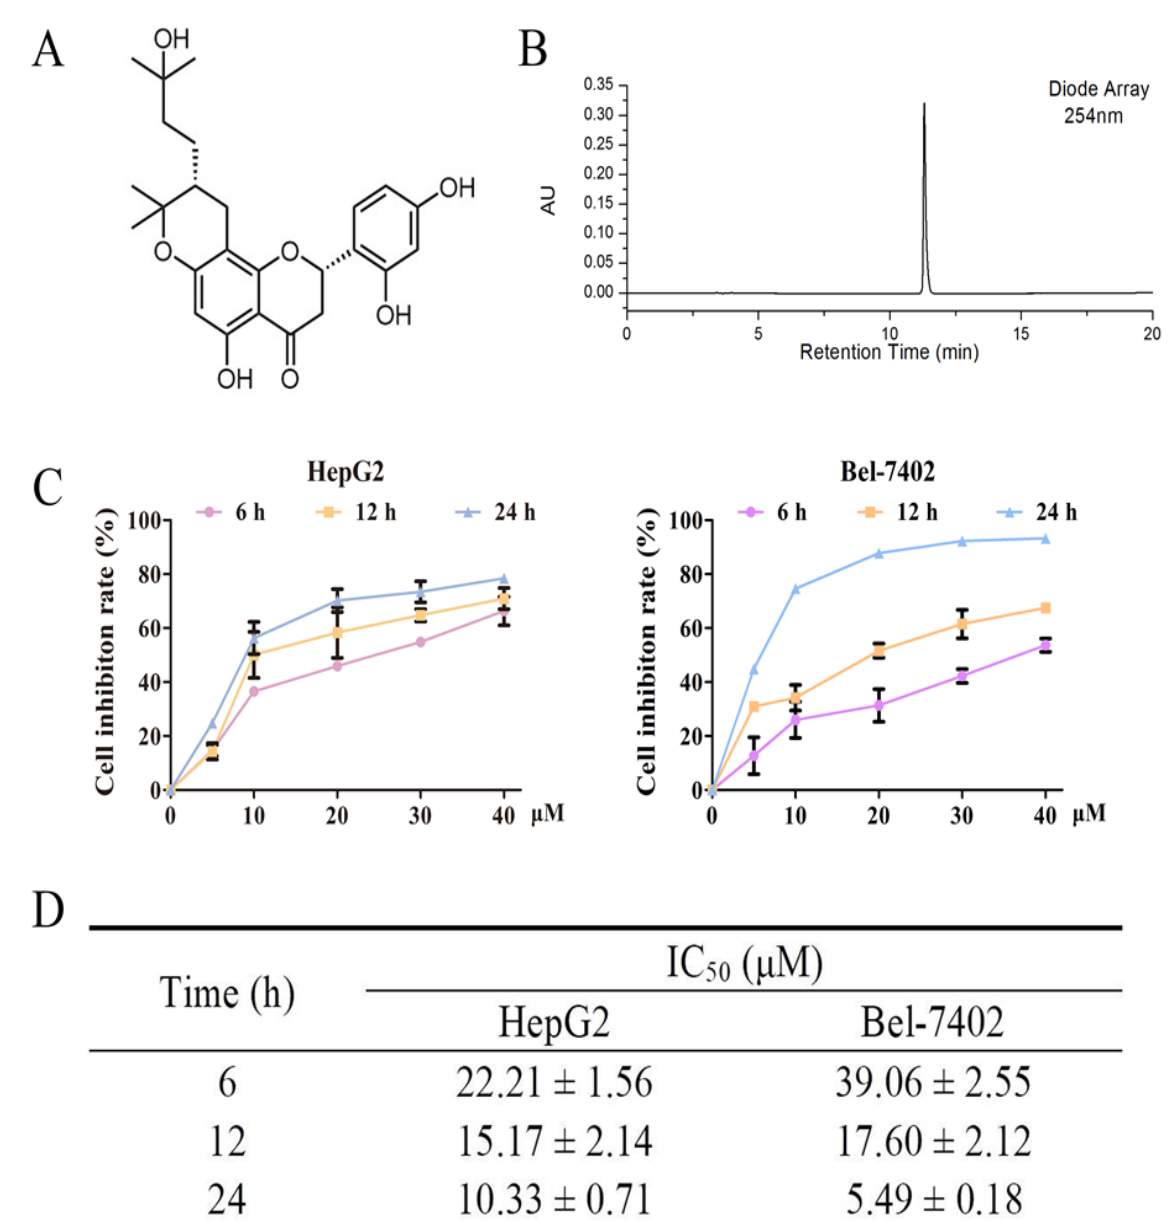
Figure 1. Davidone C-induced apoptosis of human hepatocellular carcinoma cells. ( A ) The chemical structure of davidone C; ( B ) The HPLC chromatogram of davidone C at 254 nm; ( C ) The cell inhibition rate of HepG2 and Bel-7402 cells treated with the specified concentration of Davidone C; ( D ) The IC 50 values of HepG2 and Bel-7402 cells at 6, 12 and 24